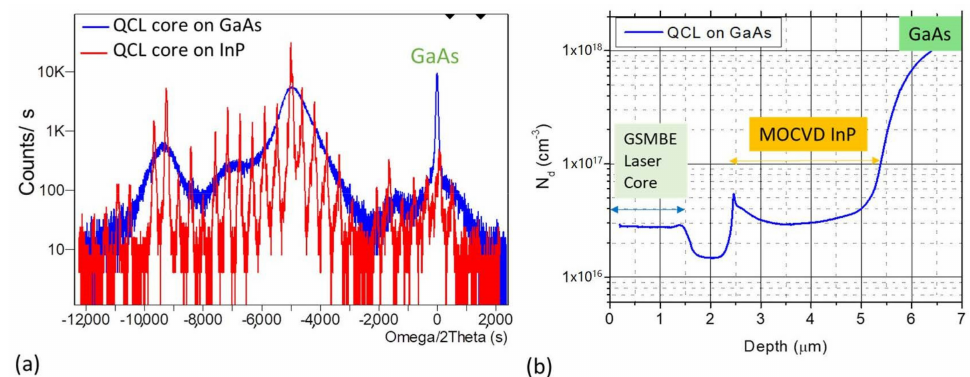
Figure 2. ( a ) Comparison of X-ray diffraction spectra for QCL cores grown on InP and GaAs substrates. ( b ) Doping profile of InP-based QCL core on GaAs